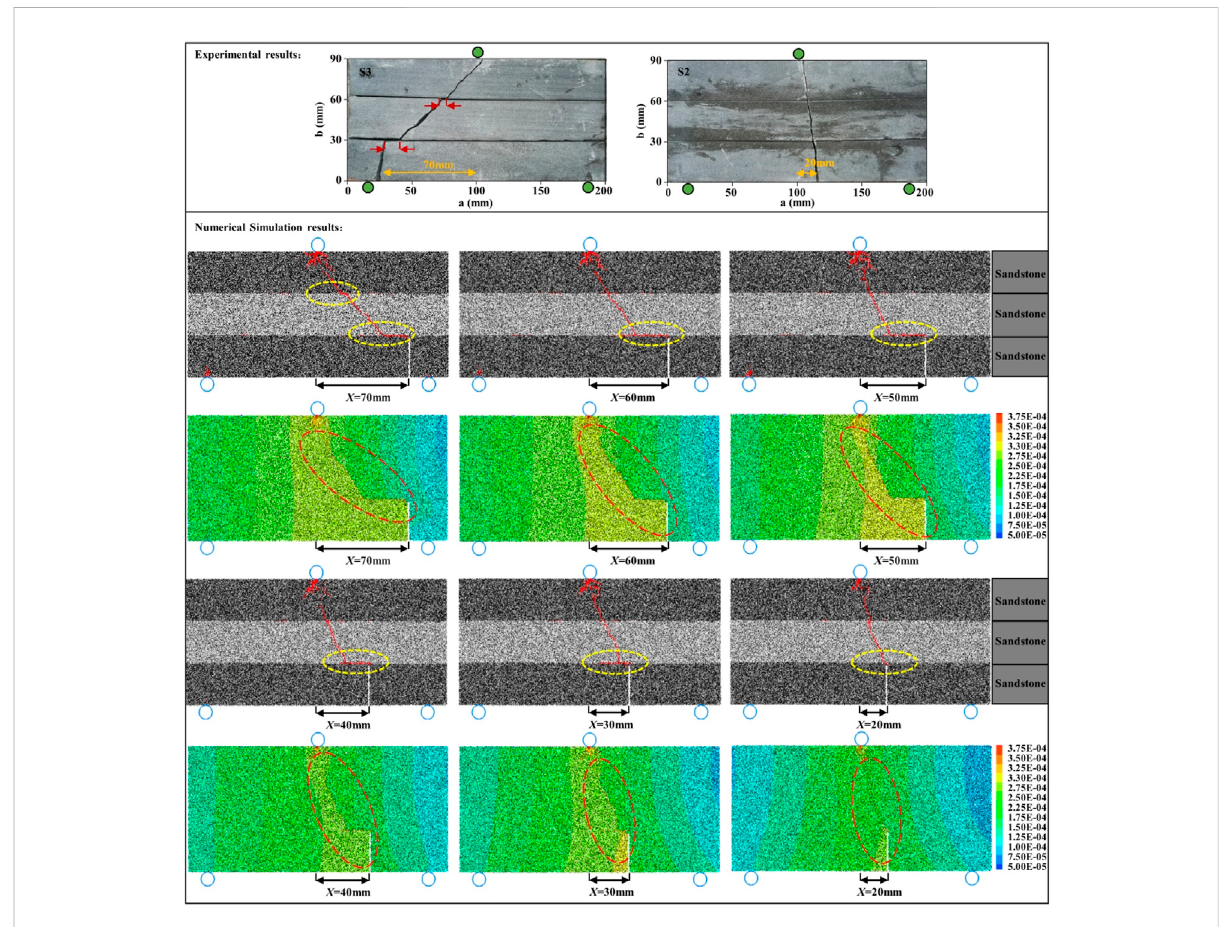
FIGURE 10 Crack propagation paths and surface displacement clouds for S-S-S model with different X